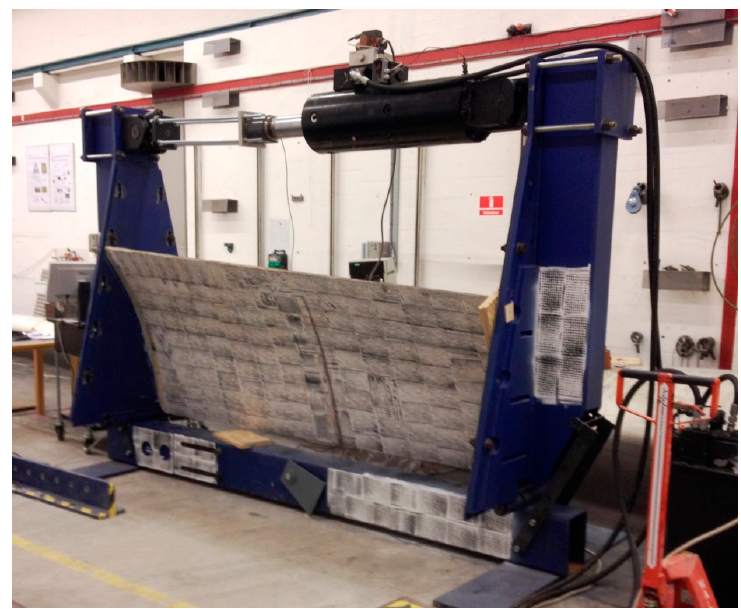
Figure 8. Full-scale testing: A 34 m long wind turbine blade subjected to static test in a combined flapwise and edgewise load direction.